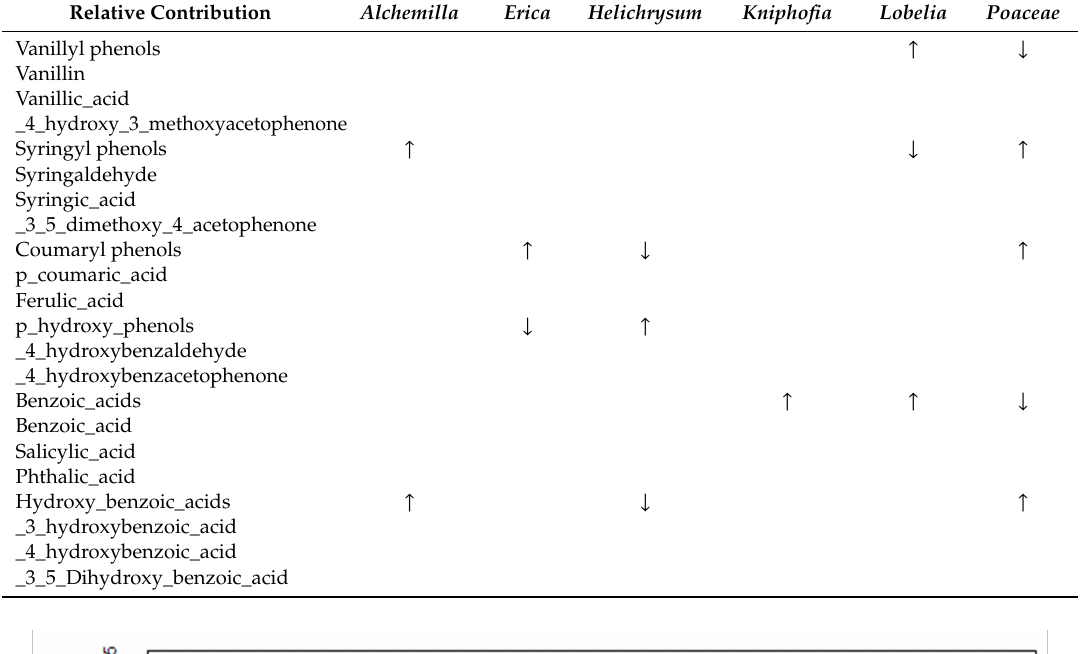
Table 1. Summary of the relative abundance of individual phenols profiled in each dominant plant species. Key: ↑ (higher) and ↓ (lower).